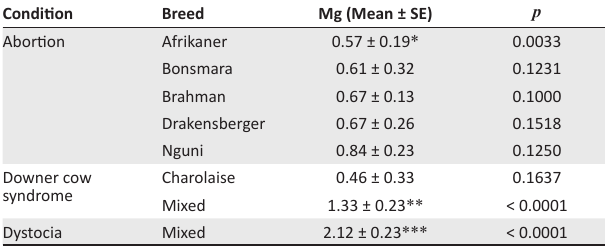
TABLE 3: Mean serum magnesium concentrations in cows presenting abortion, downer cow syndrome and dystocia in different breeds. Condition